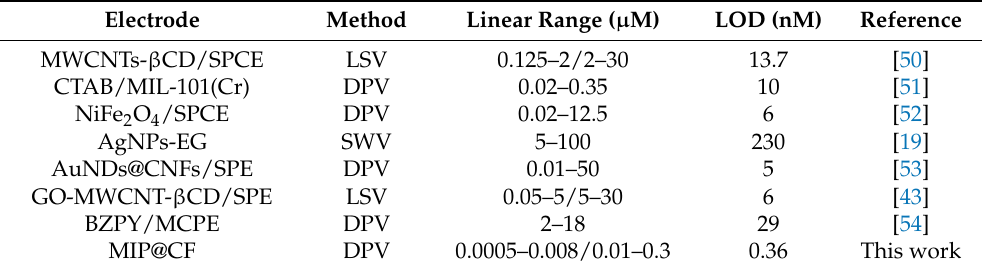
Table 1. Performance comparison of the prepared sensor for Bisphenol A detection with other sen- sors.